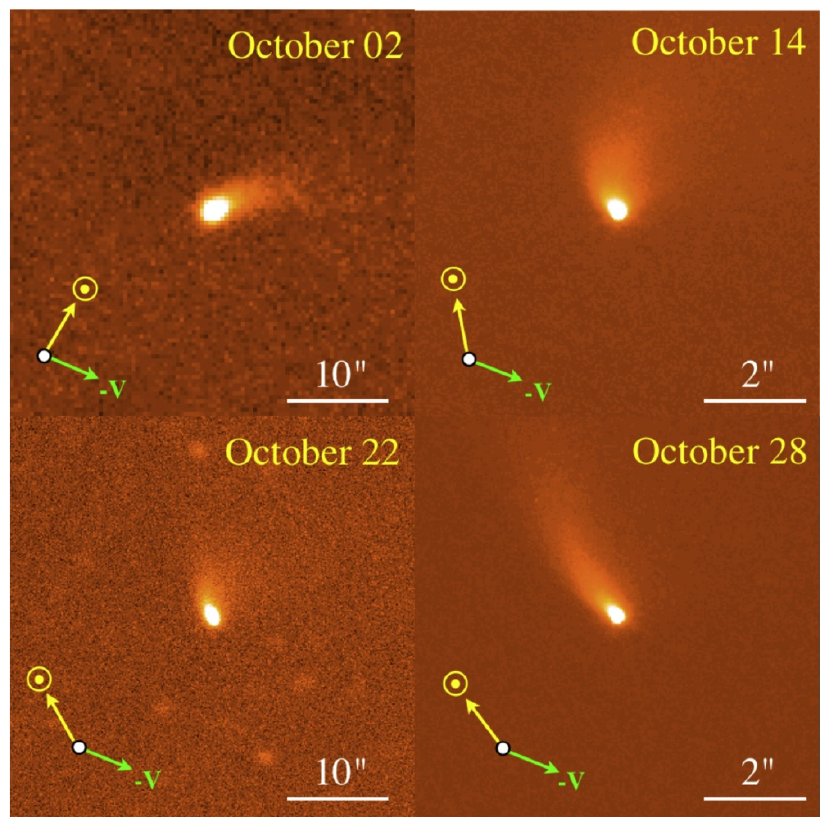
Figure 2. Images of 313P/Gibbs taken on different days of 2014 by: the Keck I telescope at Mauna Kea, Hawaii (October 2); the Danish telescope at La Silla, Chile (October 22); and the Hubble Space Telescope (October 14 and 28). The yellow arrow in each panel shows the direction to the projected antisolar vector, while the green arrow indicates the projected anti-velocity vector. In each panel north is up and east is on the left. Note the appearance quite similar to that of a classical comet, despite the considerably lower activity of this object, also characterized by the absence of detectable gaseous emission. This last feature is common to all MBCs except one (see text). (Original source: Figure 2 of [24].)